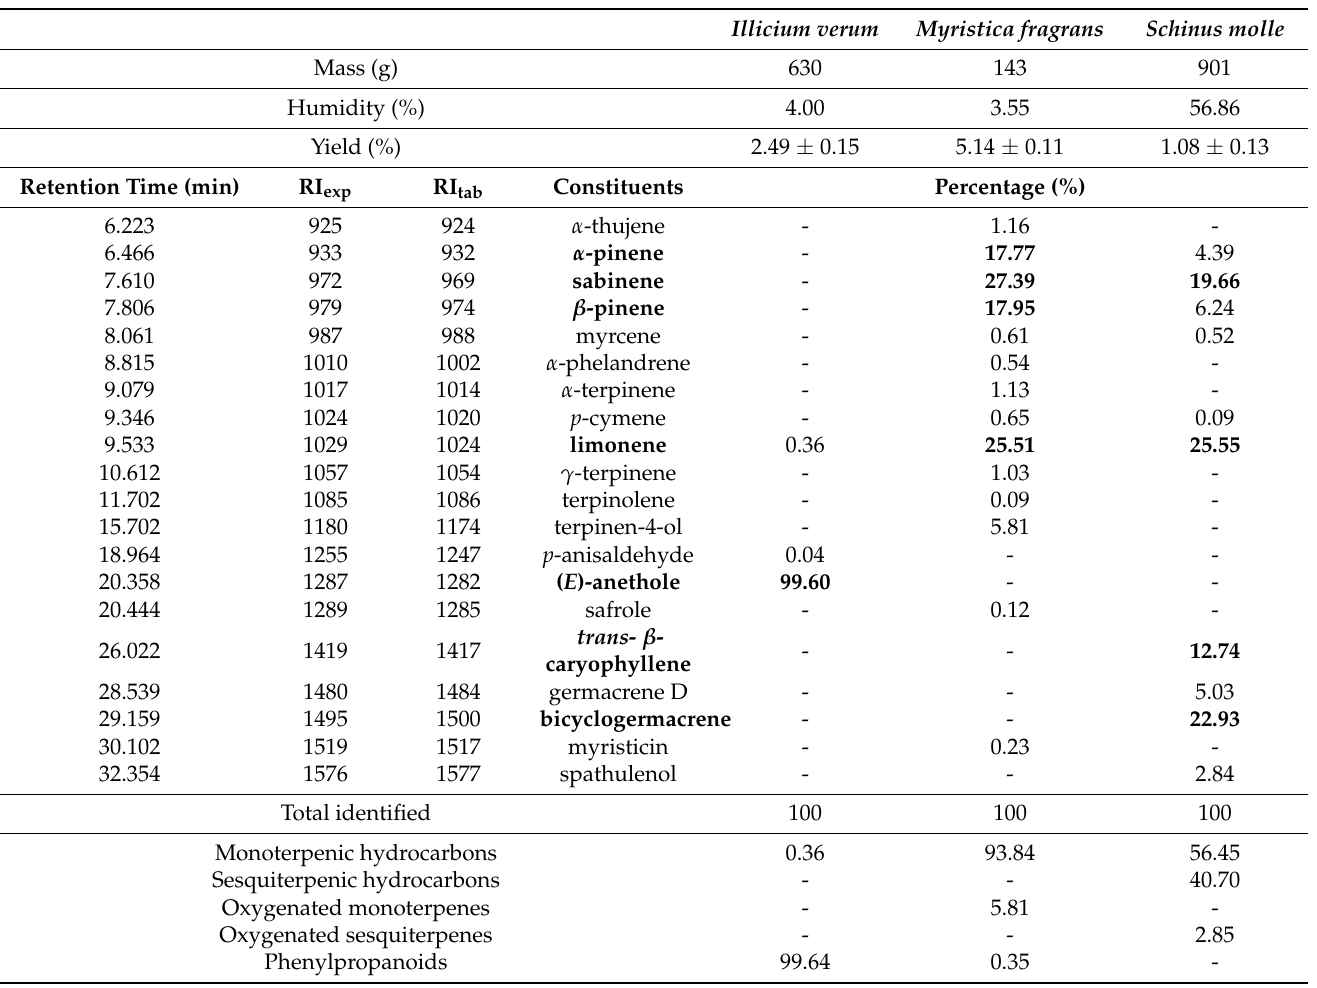
Table 1. Moisture content, yield and chemical composition of essential oils of Illicium verum , Myristica fragrans and Schinus molle